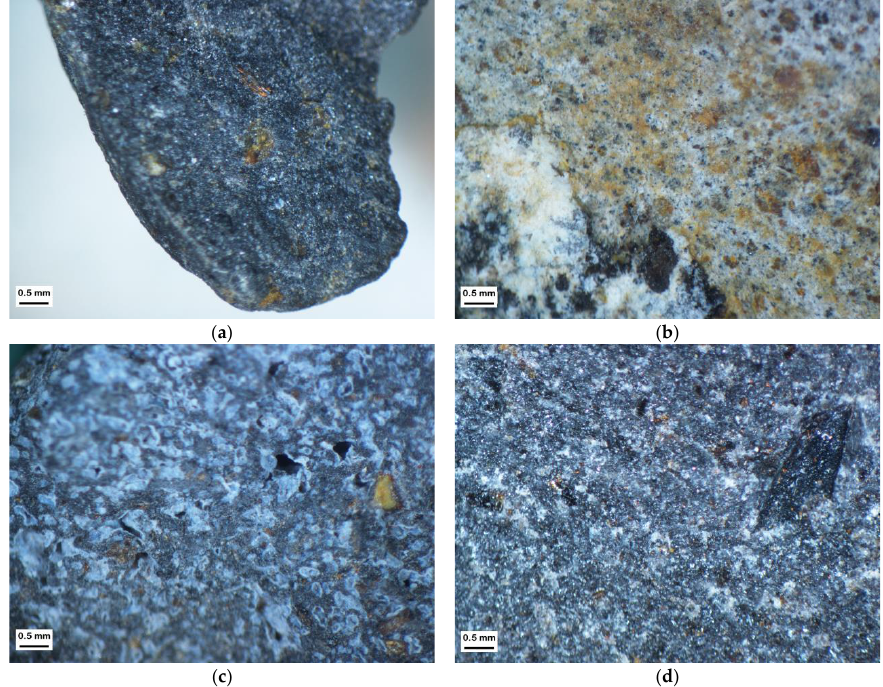
Figure A4. Characteristics of cracks in samples after crushing in cone crusher (feed—original sample): ( a ) Basalt aggregate 2, non-flaky grains, +8 mm; ( b ) Basalt aggregate 2, non-flaky grains, +16 mm; ( c ) Basalt aggregate 2, flaky grains, +8 mm; ( d ) Basalt aggregate 2, flaky grains, +16 mm.